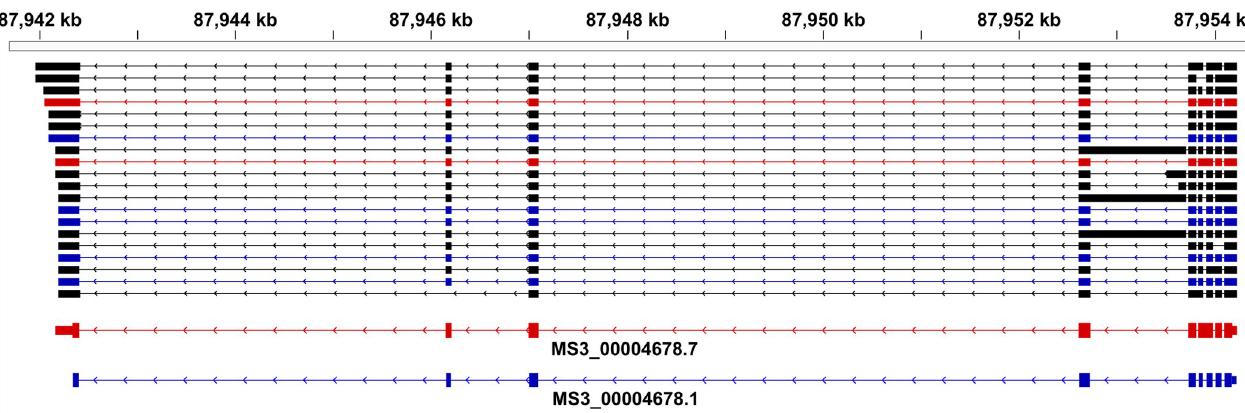
PLOS Pathogens| https://doi.org/10.1371/journal.ppat.1010288 February 15,